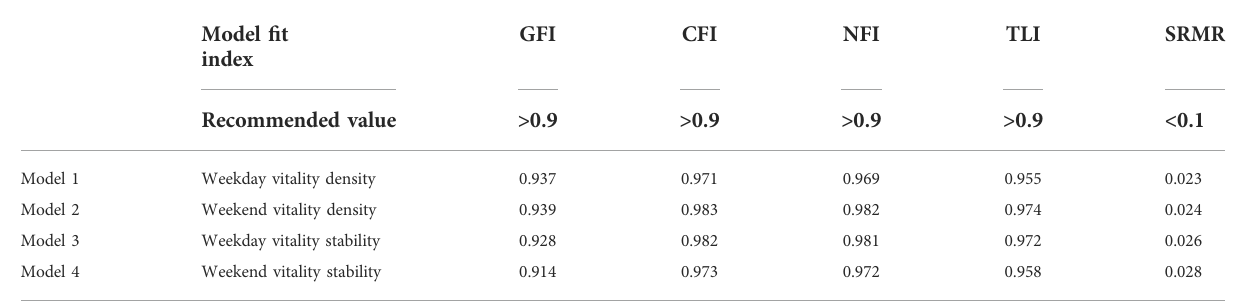
TABLE 5 Model fi t indicators.